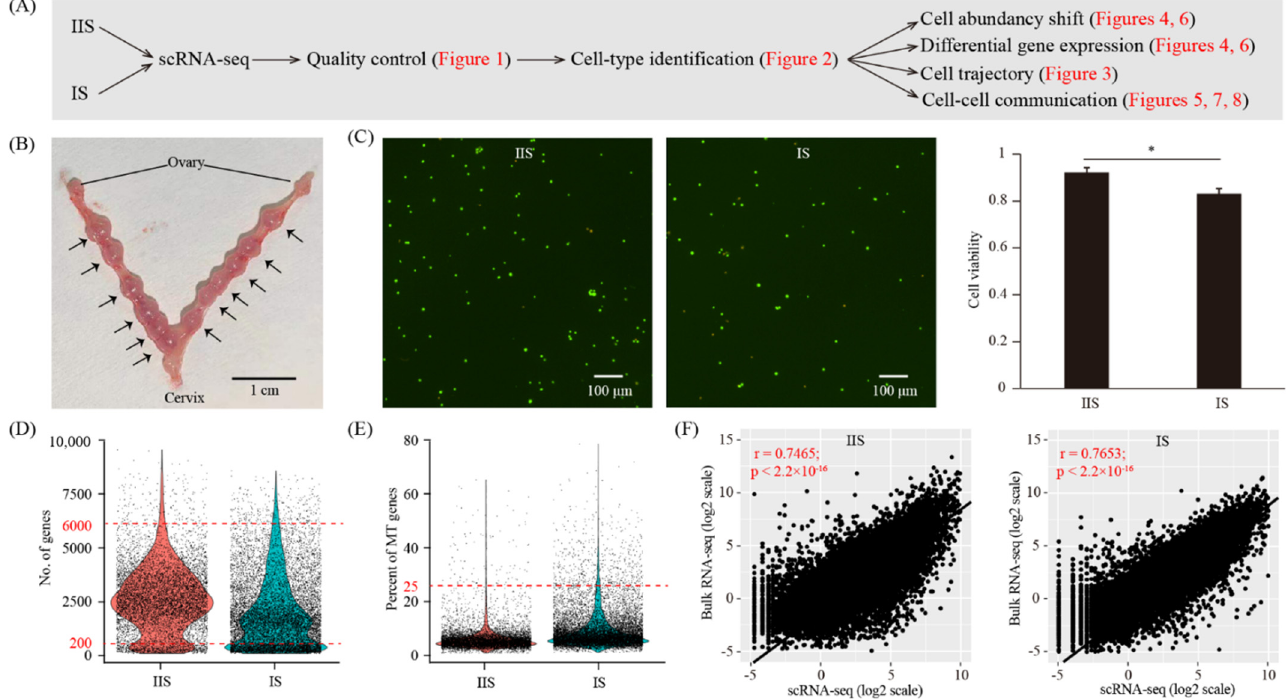
Figure 1. Single-cell transcriptome analysis of the decidualized mouse uterus on gestational day 8. ( A ) A flowchart overview of this study. IIS, inter-implantation site (undecidualized uterus, served as control); IS, implantation site (decidualized uterus). ( B ) A photograph of mouse uterus on gestational day 8. The positions of embryo implantation sites were marked with an arrow. ( C ) Cell viability analysis of single-cell suspension. Cells were stained with the AO/PI solution. Cells in green were live and cells in yellow were dead. A representative photo was provided, and a bar plot was shown on the right. n = 3; * p < 0.05. ( D , E ) Single-cell RNA-seq data pre-processing and quality control. Cells with detected genes of fewer than 200 or more than 6000 were removed. Only cells with total mitochondrial gene expression below 25% were kept. ( F ) Scatter plots showing the correlation between single-cell RNA-seq and bulk RNA-seq. For single-cell RNA-seq data, gene expression levels were averaged and normalized as transcript per million (TPM). For bulk RNA-seq data, gene expression levels were measured as fragments per kilobase per million (FPKM).